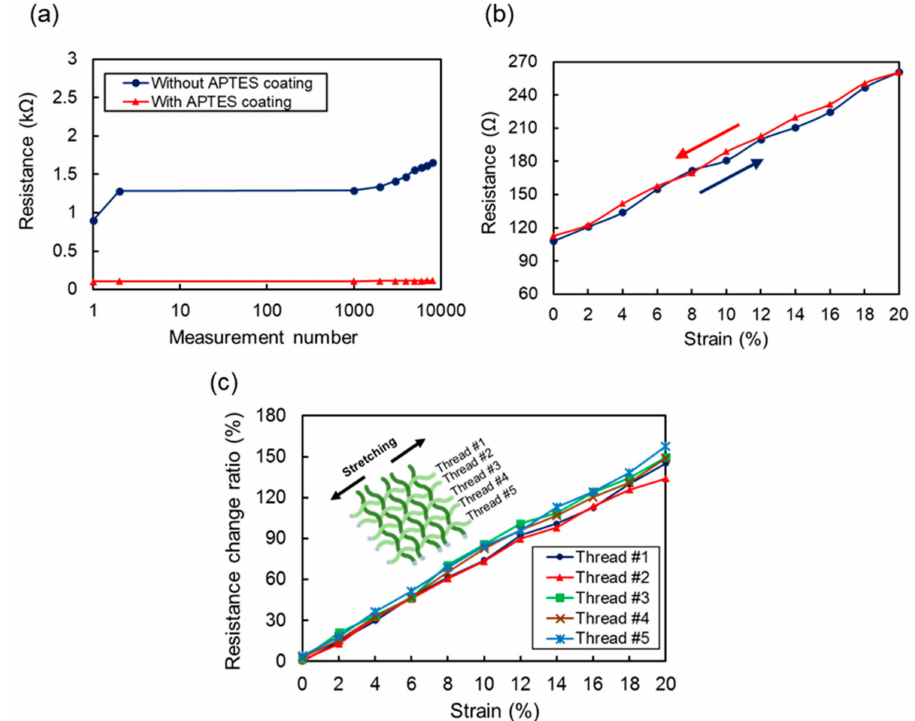
Figure 10. ( a ) Comparison of durability test using devices with and without APTES coating on hollow tube when lateral force was applied up to 20% strain for 8000 times. ( b ) Hysteresis response of single thread measured while lateral force was applied to increase (navy color) and decrease (red color) the strain gradually. ( c ) Sensitivity variation between five functional